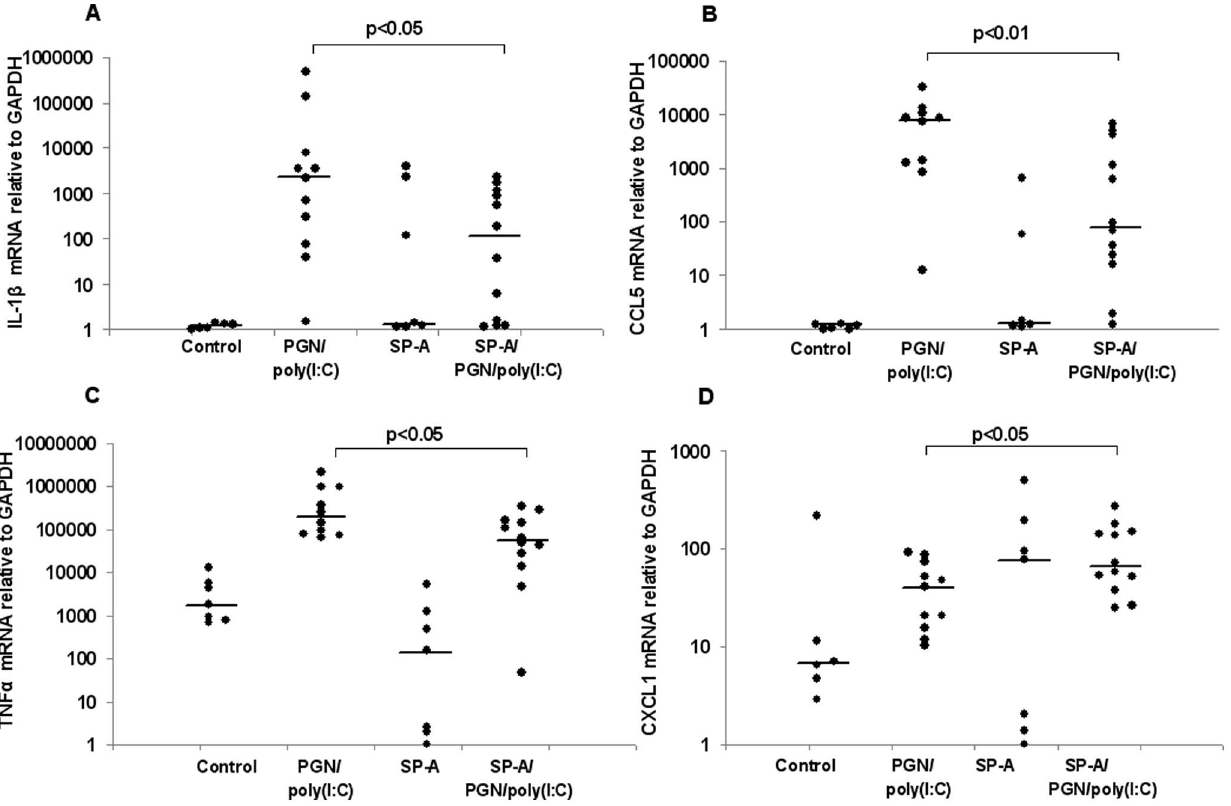
Figure 6. Effect of SP-A on the TLR ligand-induced expression of inflammation markers in the placenta. RT-PCR analysis of mRNA for IL- 1 b (A), CCL5 (B), TNF- a (C) and CXCL1 (D) normalized to GAPDH in placentas collected from CD-1 mice on day 14.5 of a 19- to 20-day gestation 8 hours after intrauterine administration of either PBS or PGN + poly(I:C) with or without SP-A. No transcripts were detected for IL-10. Data depicted are expression levels of cytokine for individual mice. N=7 for control, n=11 for PGN/poly(I:C), n=7 for SP-A and n=12 for SP-A/PGN/poly(I:C). Median values are depicted by a short straight line. P values were calculated by Mann-Whitney U test and compare PGN + poly(I:C) with and without SP-A.